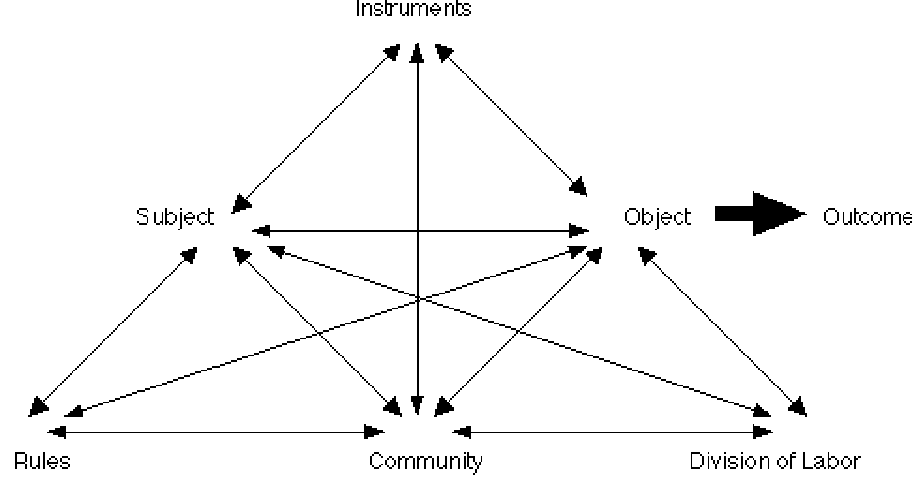
Figure 3 . Components of an activity system (from Engeström,